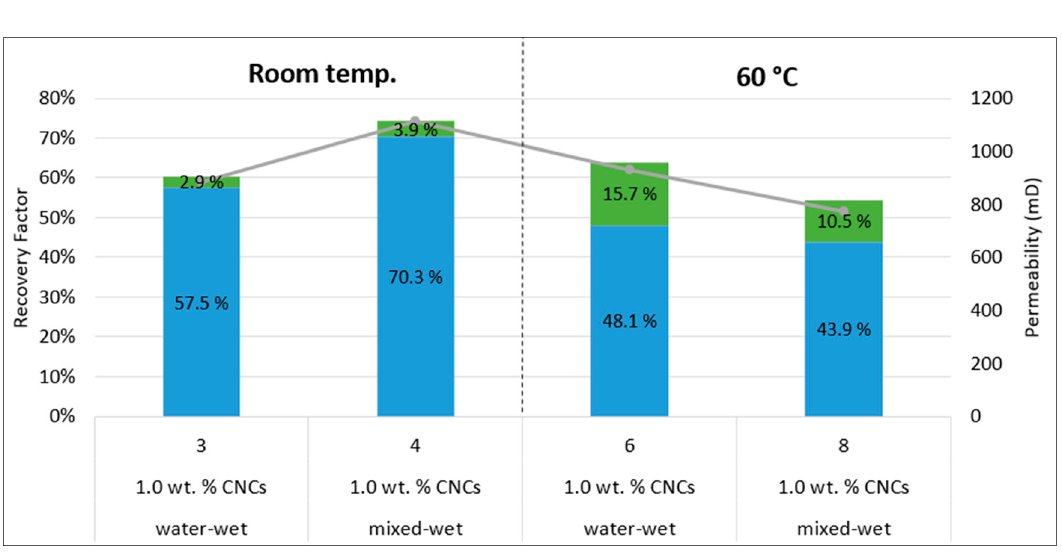
Figure 7. Recovery factors (% of OOIP) of tertiary recovery experiments. The vertical black dotted line acts as a marker between the experiments conducted at room temperature and 60 °C. Blue color represent the recovery factor achieved from low and high rate water flooding, while the green color denotes the recovery from the low and high rate nano flooding.